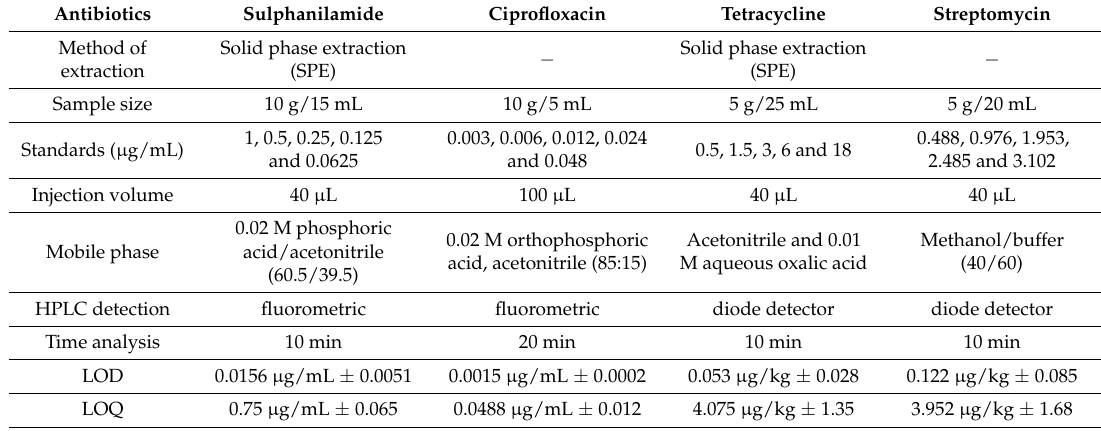
Table 4. Detection methods of antibiotics in meat through high-performance liquid chromatography (HPLC). Antibiotics Sulphanilamide Ciprofloxacin Tetracycline Streptomycin Method of